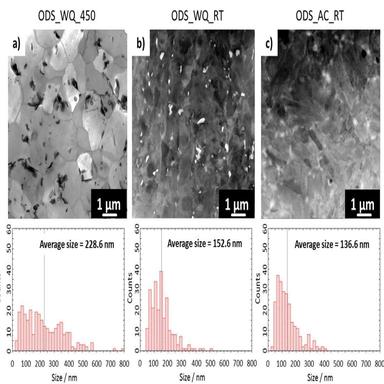
Bright field STEM image of a) ODS_WQ_450 along with HAADF-STEM images of b) ODS_WQ_RT and c) ODS_AC_RT showing the sub-micron particles along with their size distributions.